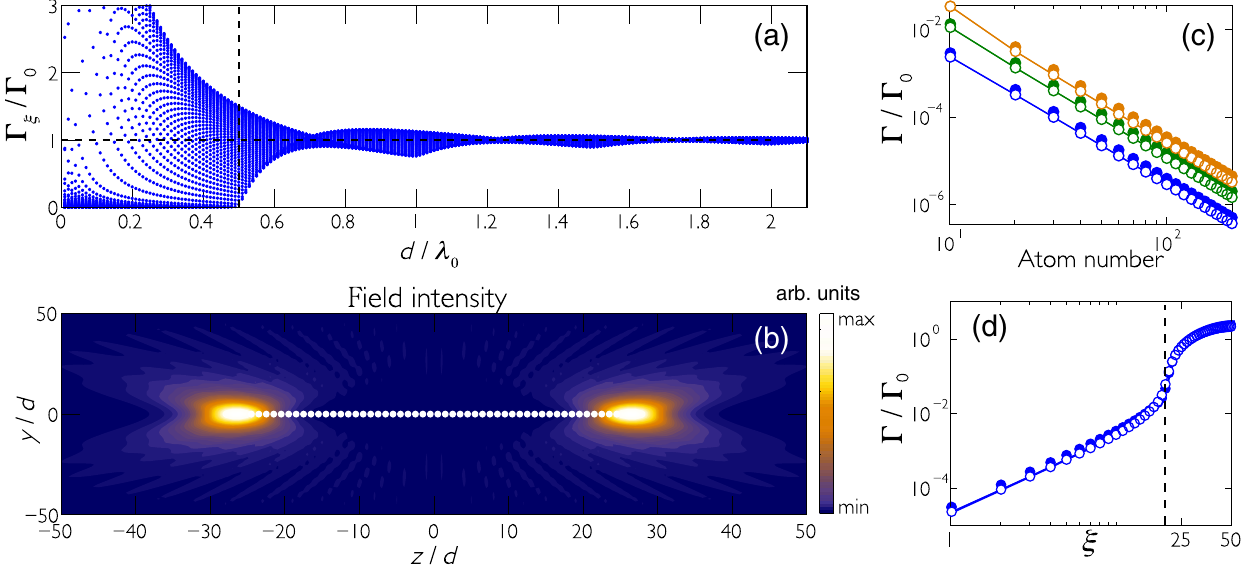
FIG. 3. Single-excitation collective modes in a finite 1D chain of two-level atoms with polarization along the chain. (a) Decay rates of the N modes at different lattice constants d= λ 0 for a finite chain of N ¼ 50 atoms. Subradiant modes arise only if d= λ 0 ≤ 1 = 2 . Avertical cut at the fixed value of d= λ 0 ¼ 0 . 2 corresponds to the blue circles depicted in Fig. 1(c). (b) Field intensity (arb. units) in the ˆ y - ˆ z plane ( x ¼ 5 d Þ created by the most subradiant mode in a chain of N ¼ 50 atoms. The field is largely evanescent transverse to the bulk of the chain, while most of the energy is radiated out through scattering at the ends of the chain. White circles denote atomic positions. (c) Scaling with atom number of decay rates for the three most subradiant modes. A fit for large N yields Γ ∼ N − 3 . (d) Scaling with mode index ξ of decay rates at fixed N ¼ 50 . Here, ξ is used to label the magnitude of the decay rates in increasing order ( ξ ¼ 1 is the most subradiant state, while ξ ¼ N has the largest decay rate). A fit for small ξ yields Γ ∼ ξ 2 . Open and solid symbols denote the results obtained by exact diagonalization and from the ansatz of Eq. (11), respectively. The black dashed line corresponds to the eigenstate whose dominant wave vector k crosses the light line ( k ¼ k 0 ). (b) – (d) are for d= λ 0 ¼ 0 . 3